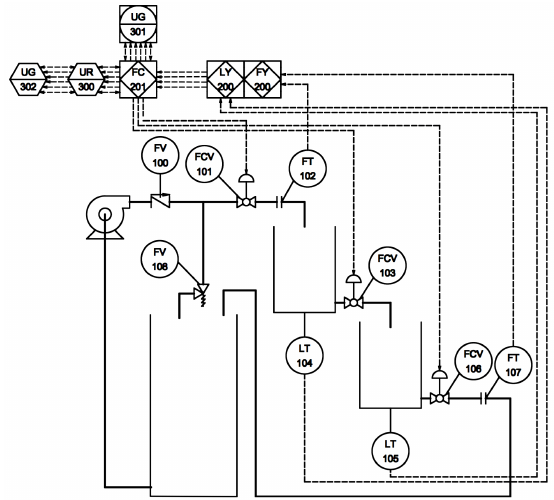
Figure 1. P&ID diagram of the multi-tank